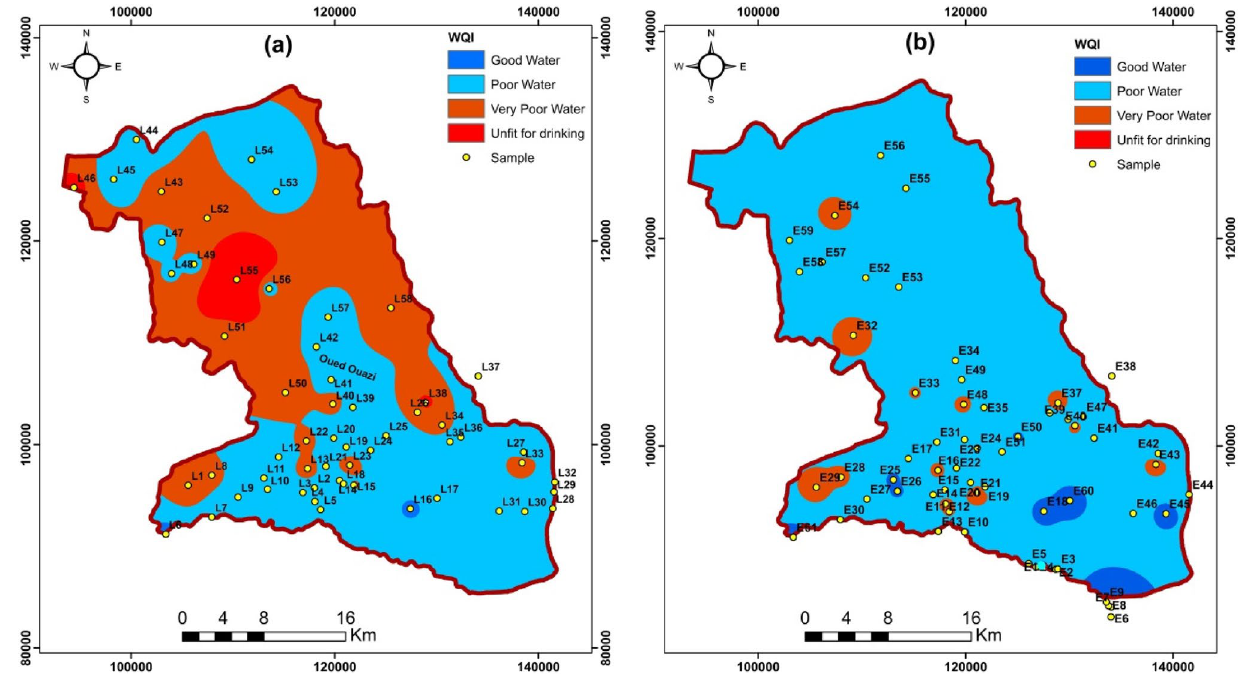
Fig. 8 Spatial distribution map of WQI values in the Meskala-Ouazzi sub-basin in the campaigns 2019 and